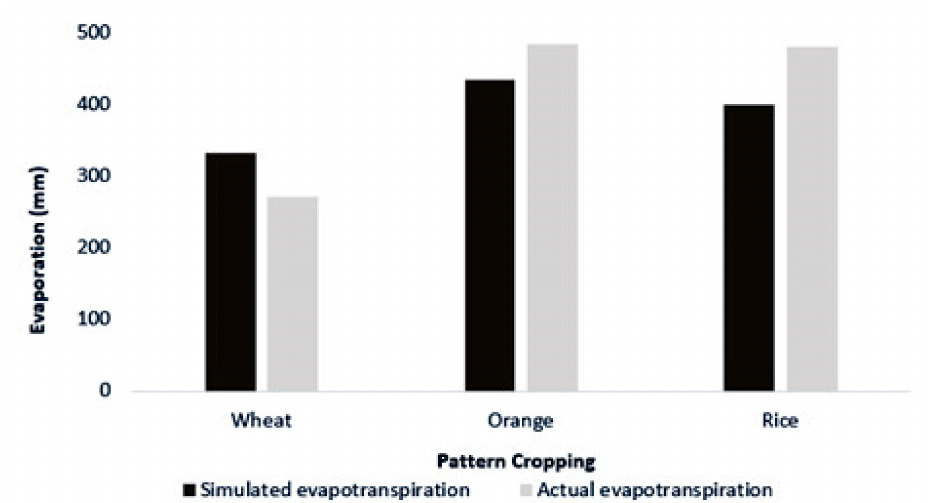
Figure 5. Simulation values and the reported values of the National Water Document.